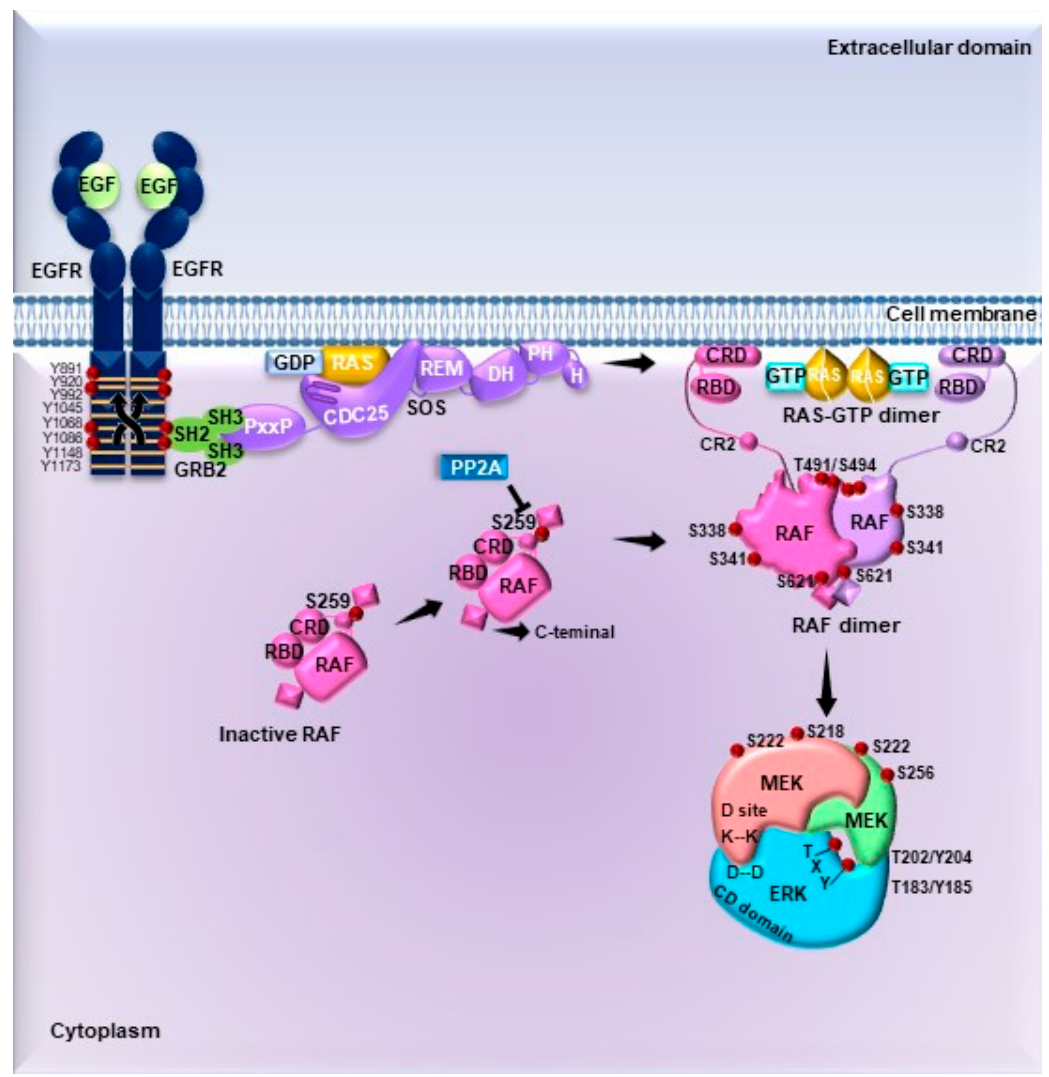
Figure 2. Epidermal Growth Factor Receptor-dependent activation of the MAPK signaling pathway.